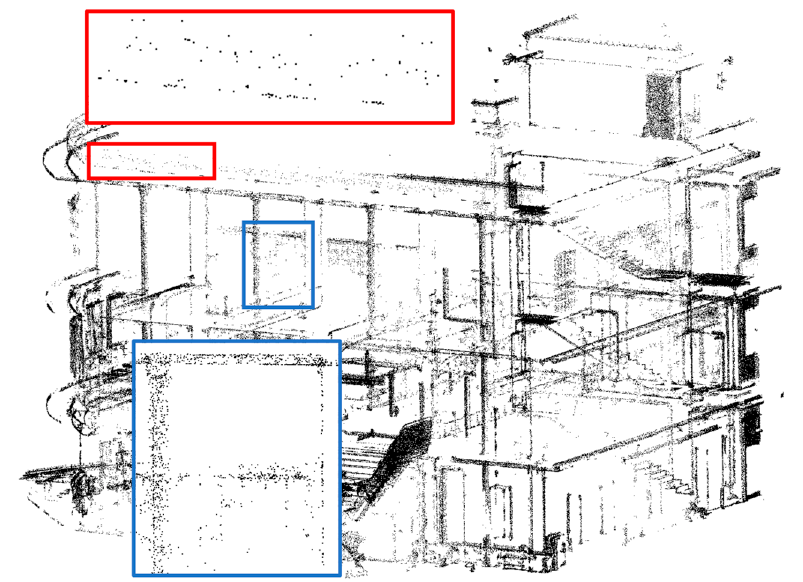
Figure 13. Edge points extracted from the 3D laser-scanned points in Figure 12. We use these edge points for our comparative study of the upsampling. Each large rectangle shows the enlarged image of the area indicated by the small rectangle with the same shape.